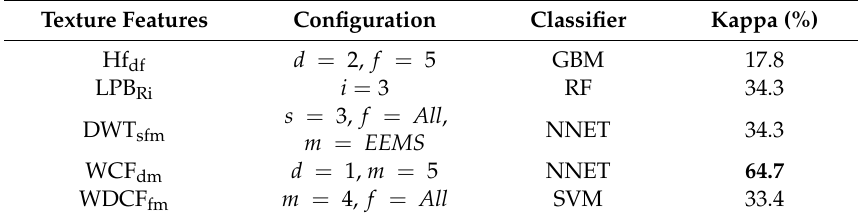
Table 3. Highest kappa (in %) achieved by each family of texture descriptors, with the parameters’ values and classifier for which such kappa was achieved.